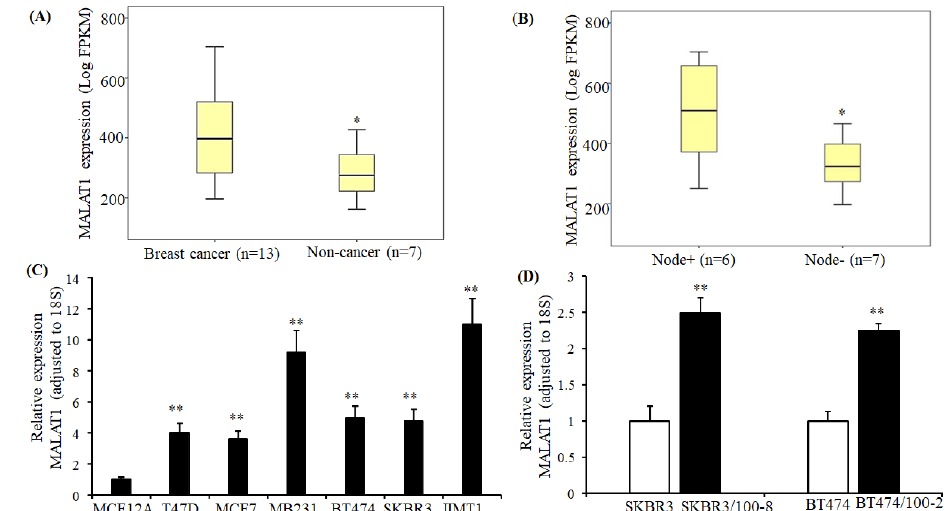
Figure 1. MALAT1 expression in breast cancer tissues and cell lines. ( A ). Tissue samples from breast cancer and non-cancer tissues were examined by mRNA-sequencing, as described in Methods. The box shows the range of expression of MALAT1 in breast cancer and non-cancer tissues and the horizontal line the median level. High MALAT1 expression was detected in breast cancer tissues, * p < 0.05 compared to non-cancer tissues. The Mann-Whitney U test determined the significance; ( B ). Tissue samples from breast cancer patients were grouped with and without lymph node involvement. The box shows the